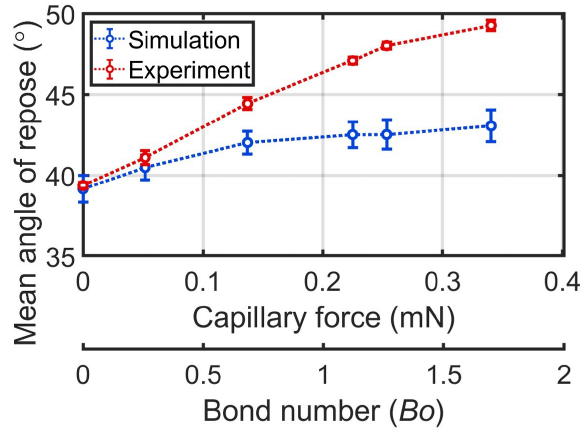
Figure 6. Experimental vs. numerical angle of repose as a func- tion of the capillary force and the Bond number. Experiments are obtained from Ref. [1].